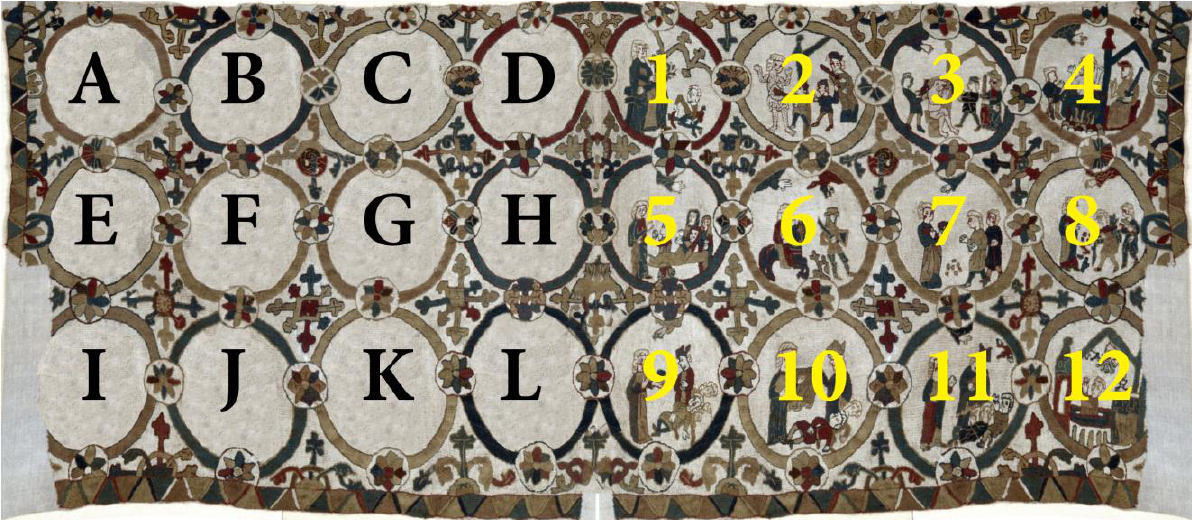
Figure 7. The Svalbarð cloth doubled with mirroring of the basic structure (© Guðjón Þór Erlendsson). Circle 1 . The first circle is red and marks a focal point in the story. It draws the eye to the main character who is a woman from a noble family. The woman has a falcon in her lap, the heraldic symbol of the Svalbarðingar clan. The colors of the bird’s feathers indicate the summer colors of Icelandic falcons. At her feet, a man is playing a lute with Svartur Þ ó rðarson of Hofstaðir. The lutes that angels play on the altarpiece in Skarð are of the same shape as the instrument on the